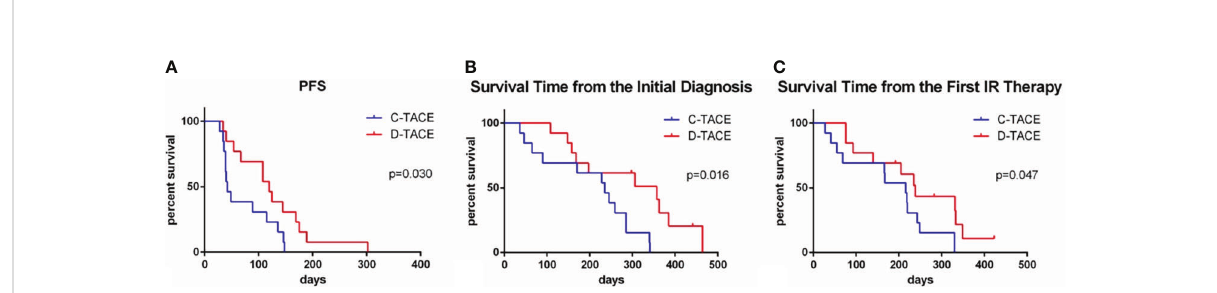
FIGURE 5 Comparison of PFS and OS in the two groups. The median progression-free survival times of the two groups were 42 and 120 days, respectively (p = 0.030). From the initial diagnosis, the overall survival times of the two groups were 235 days and 357 days (p=0.02). From the fi rst interventional procedures, the overall survival times of the two groups were 216 days and 239 days, respectively (p=0.047).